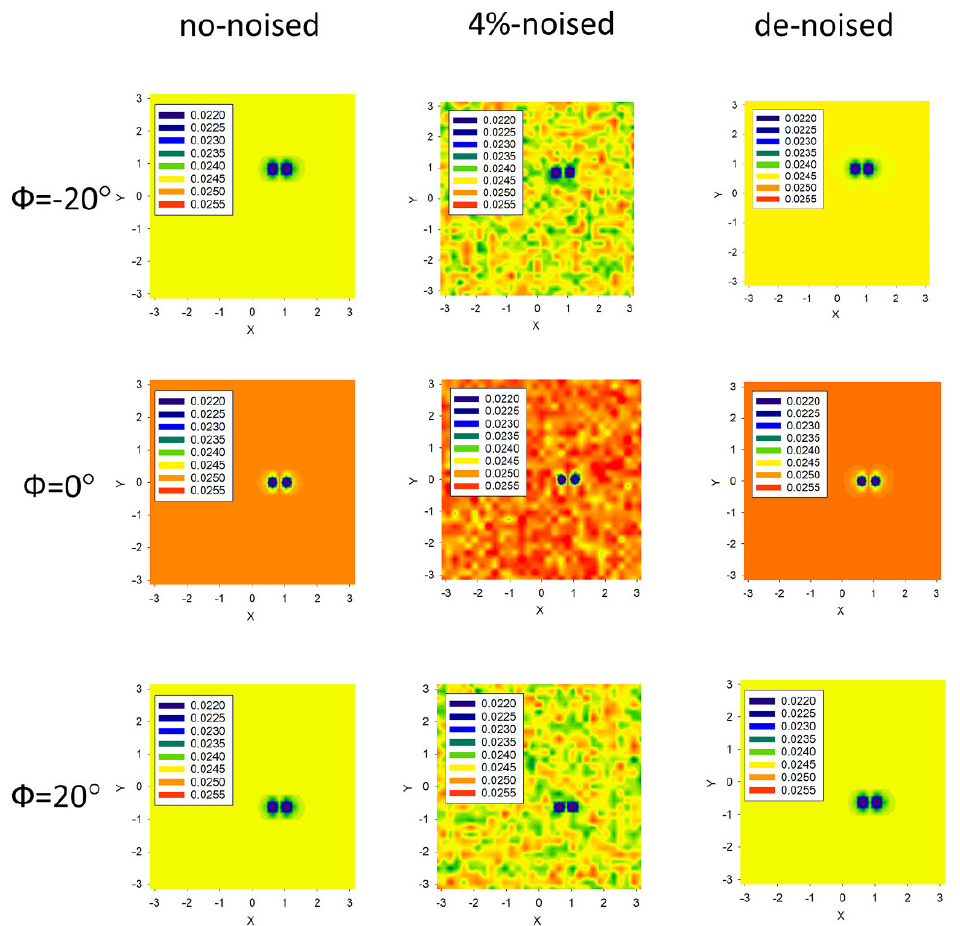
Figure 3. The 2D IPs: no-noise level (left), 4%-noise level (middle) and de-noised (right). The number of non-averaged IPs data frames is equal to 100. The sample rotation angles Φ are equal to { − 20°, 0°, 20°}, respectively.